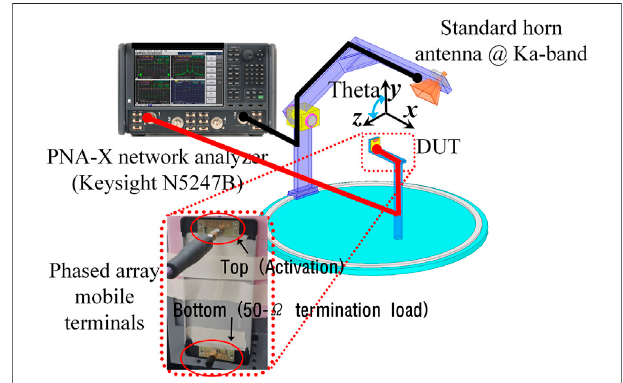
FIGURE 6 | (A) Measured end- fi re gain (+y) in free space. (B) Measured end- fi re gain (+y) in handset mockup.